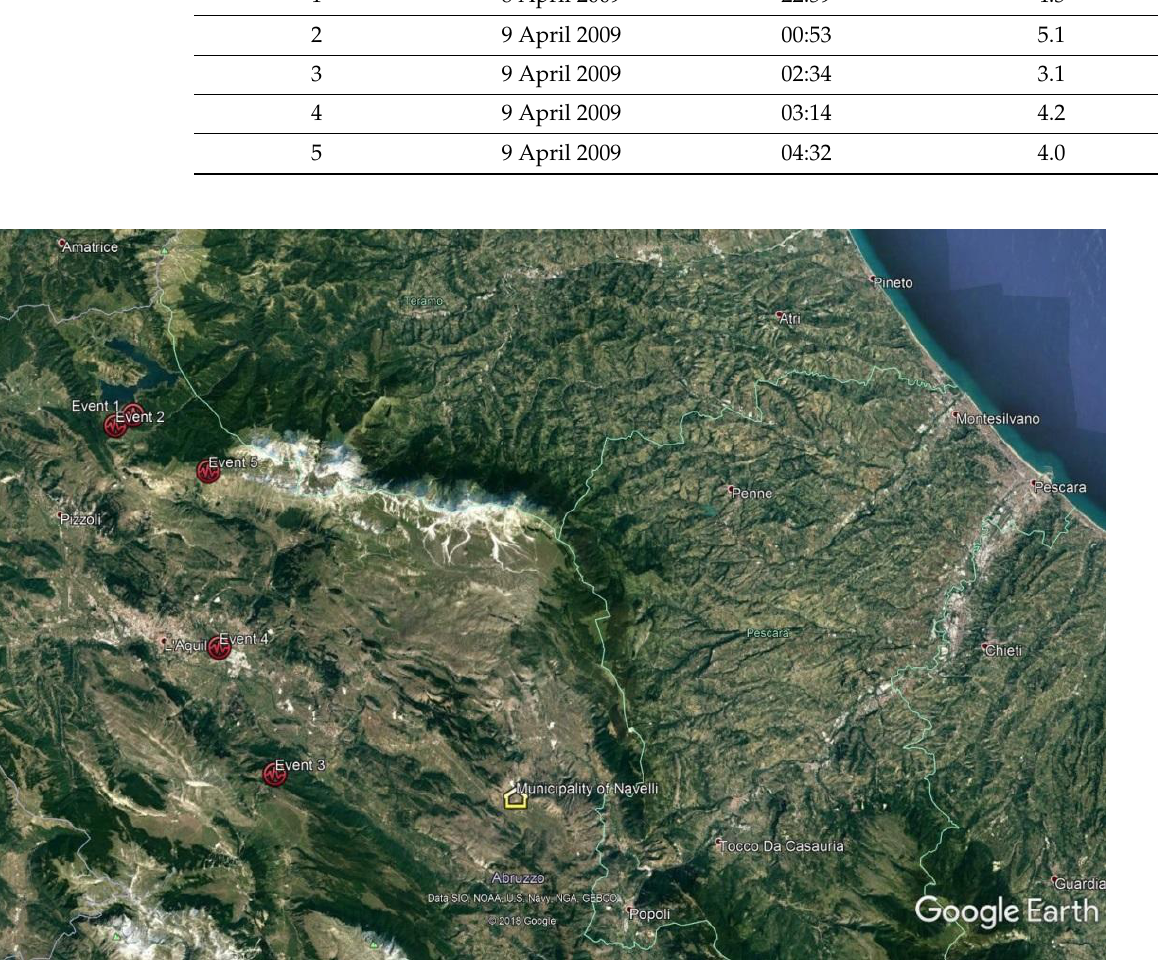
Figure 20. Map of the selected seismic events used in the analysis, from Google Earth.